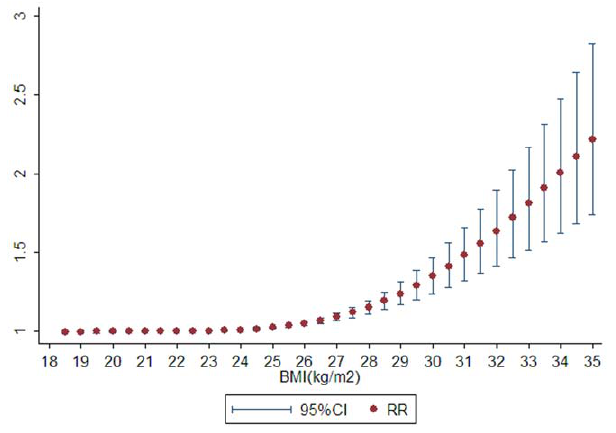
Figure 2. Publication bias in the studies included in this meta-